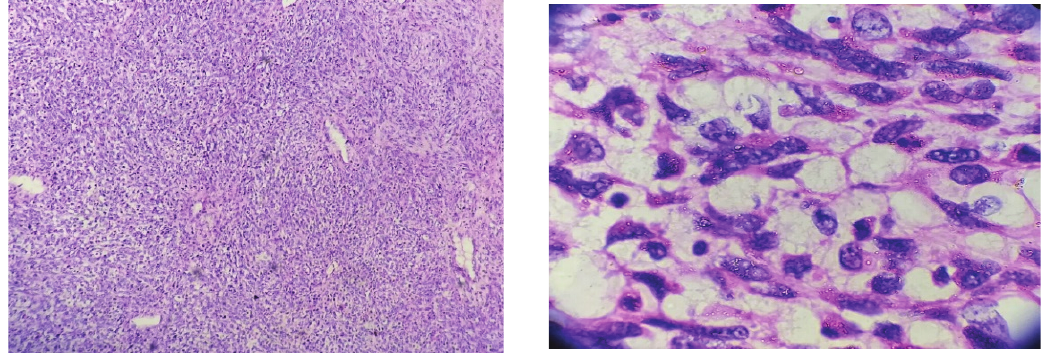
Figure 2: Collagen fibers arranged in parallel fashion : Hematoxylin-eosin stain; magnification x 10 (left) and x 40 (right).